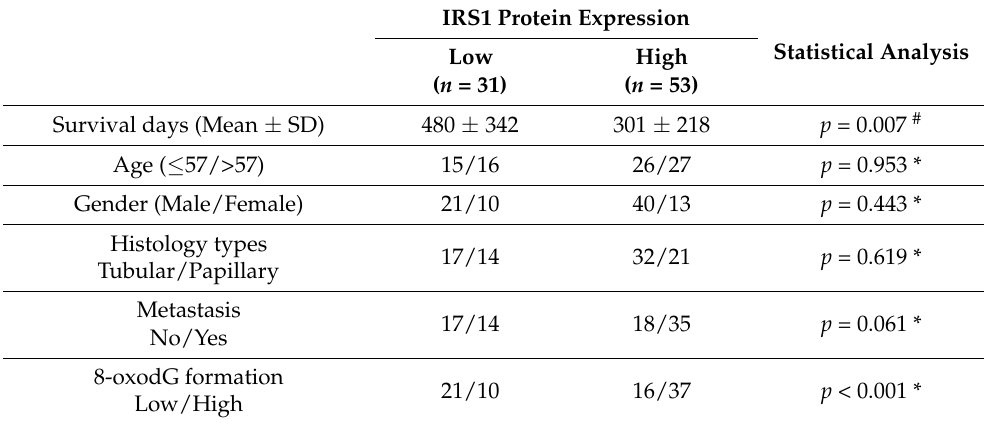
Table 1. The association between IRS1 expression patterns and clinicopathological features of CCA